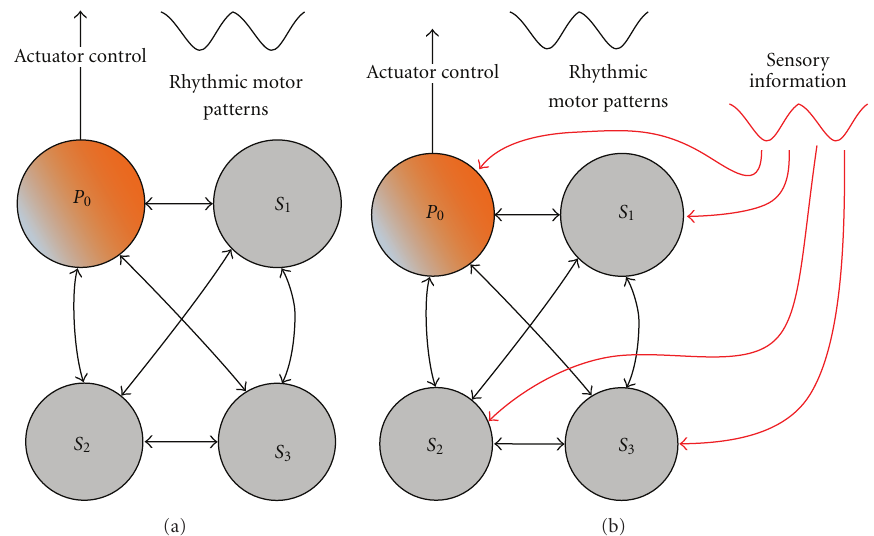
Figure 2: Illustrative representation of the assembly of neurons forming the autonomous neuromorphic (shown in (a)) and nonautonomous Neuromorphic (shown in (b)) controllers. “ P ” notation is used for primary neuron directly controlling the actuator of the robot under control and “ S ” is the secondary neuron, which aids in generating appropriate external dynamics required for the primary neuron. The numbering of the neurons in the network is arbitrarily chosen as